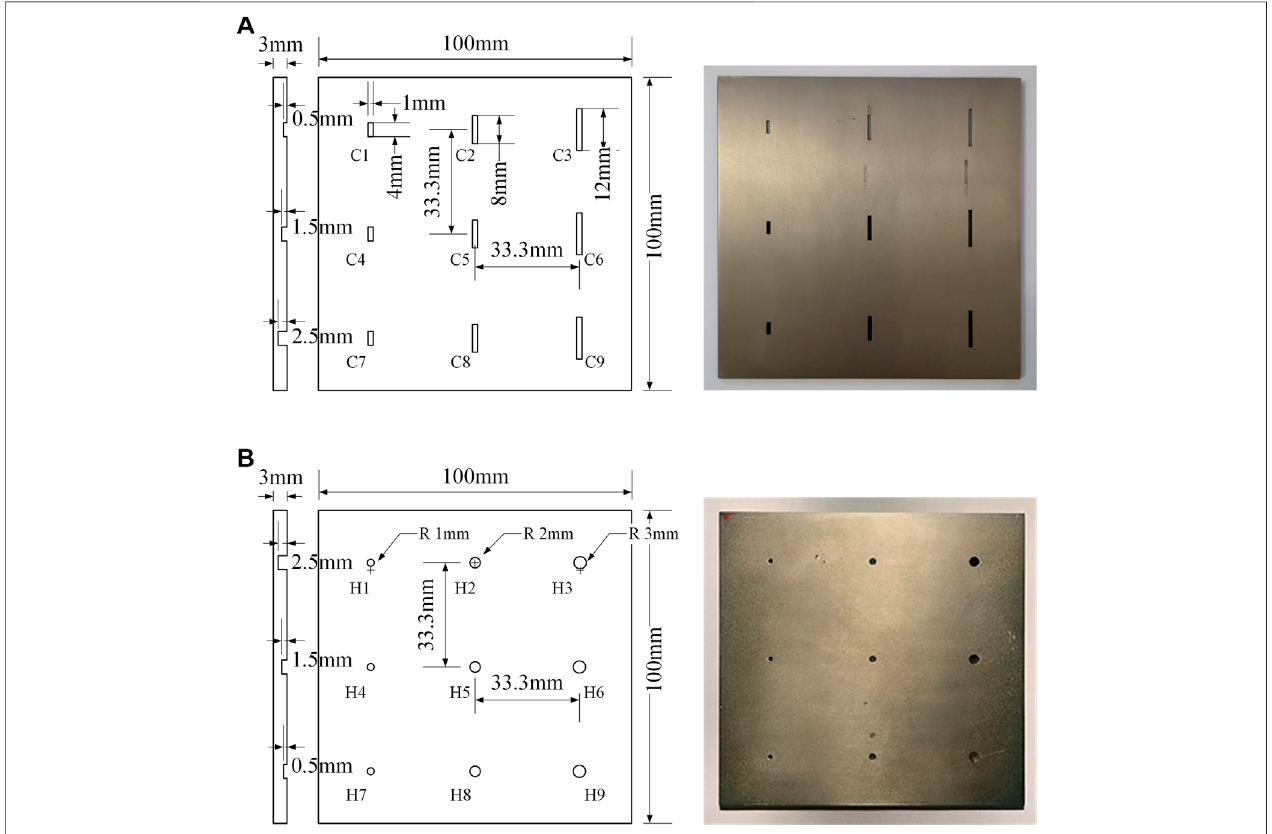
FIGURE 6 | Machined specimen: (A) specimen #1; (B) specimen